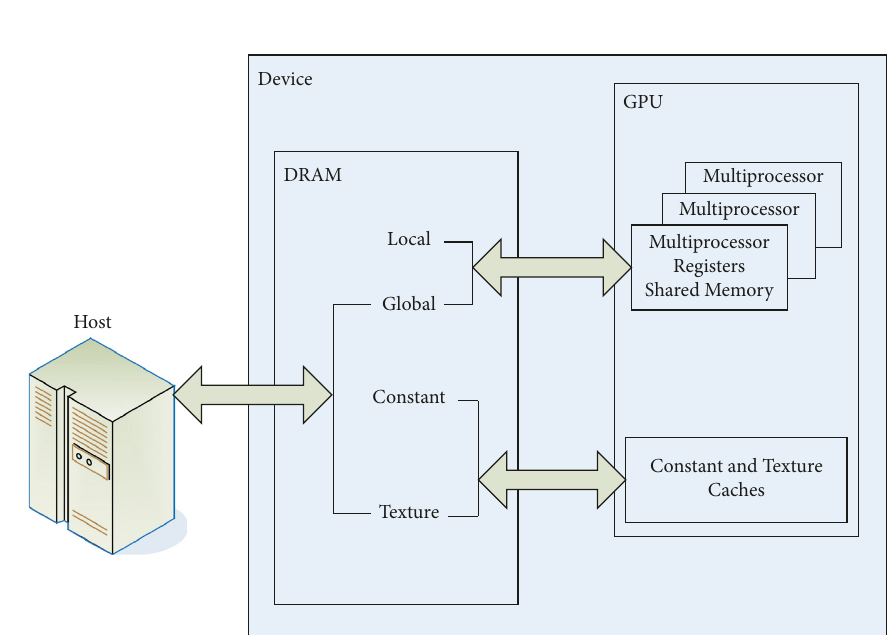
Figure 7: CUDA memory model.